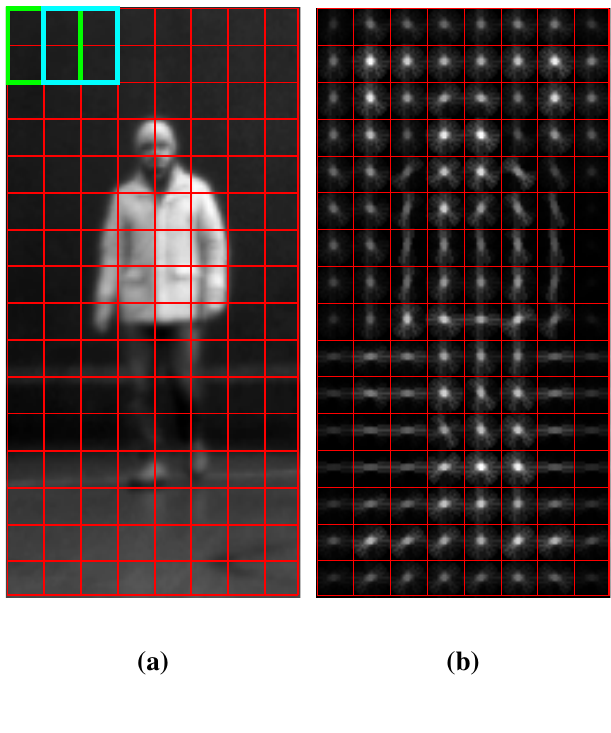
Figure 3. Histogram of oriented gradients descriptor. (a) The histogram of oriented gradients (HoG) descriptor is computed over image cells (in red) and 2 × 2 overlapping blocks of cells (green and cyan); (b) visualization of the HoG descriptor computed for the same